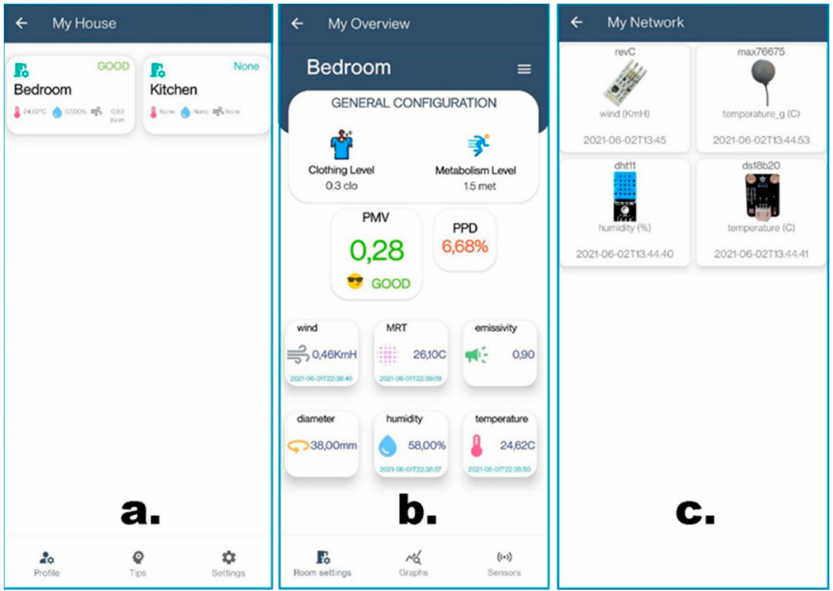
Figure 8. Screenshots of the developed application—overview: ( a ) general overview; ( b ) room overview; ( c ) sensor network